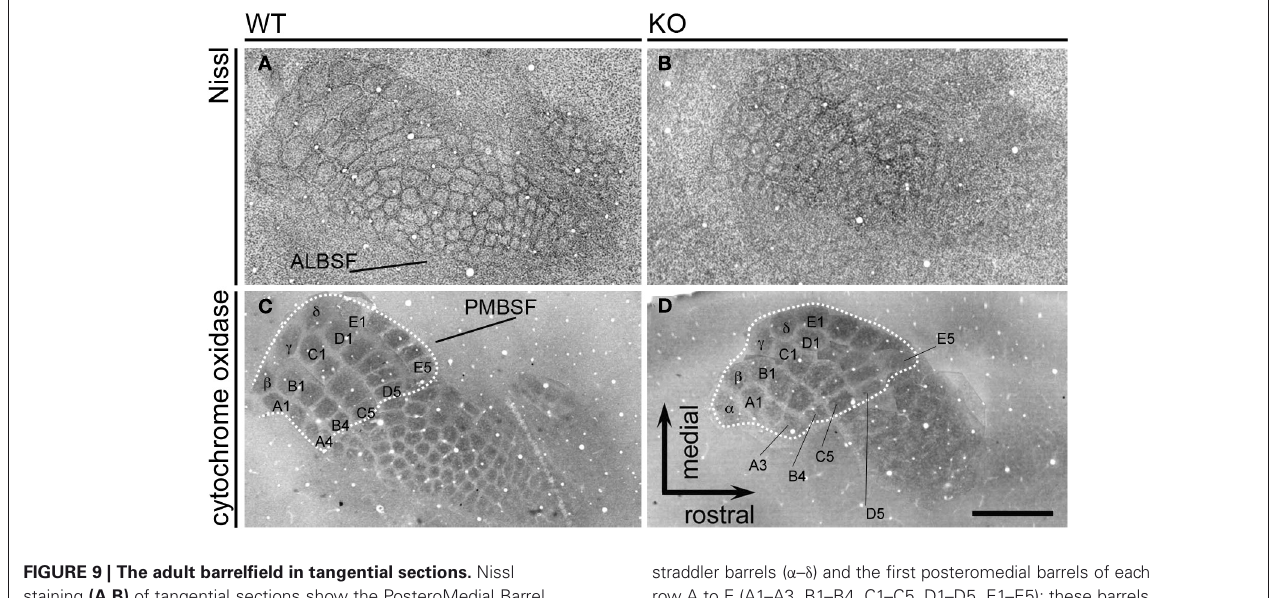
FIGURE 9 | The adult barrelfield in tangential sections. Nissl staining (A,B) of tangential sections show the PosteroMedial Barrel SubField (PMBSF) and the AnteroLateral Barrel SubField (ALBSF) subdivisions of the primary somatosensory area. The PMBSF barrels displayed blurred septa in null mutant mice, and ALBSF barrels were less distinct in mutant than in wild type mice. Cytochrome oxidase histochemistry (C,D) was used to assess possible changes in null mutant mice. The dotted lines delineate the part of the PMBSF containing the